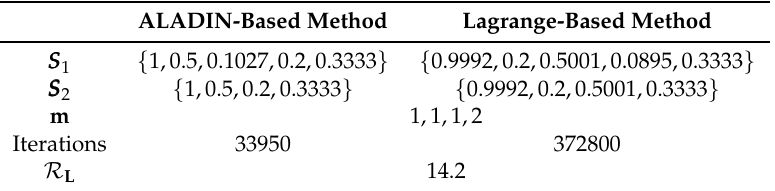
Table 2. The achievement of two methods in the sense of 6-node topology.